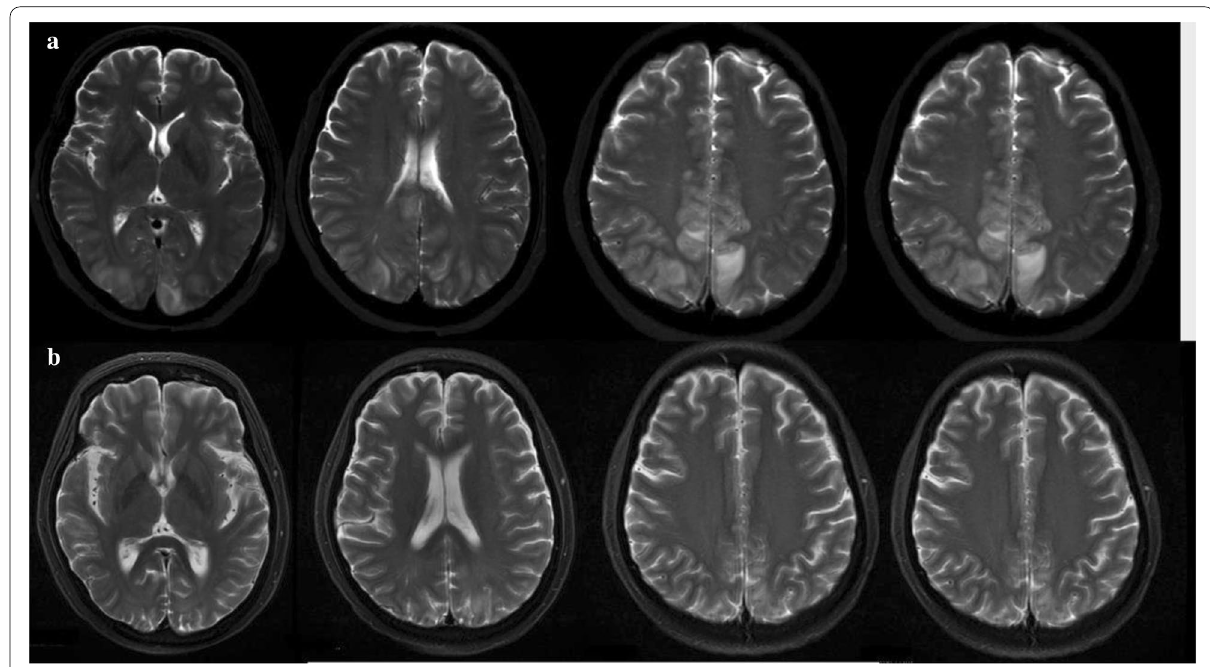
Fig. 3 a MRI of case 2 on day 38. The parietal lobe, the frontal lobe and the occipital lobe exhibited index finger-like abnormality, short T1, long T2, high FLAIR signal. b. MRI of case 2 on day 102. The signals showed significant